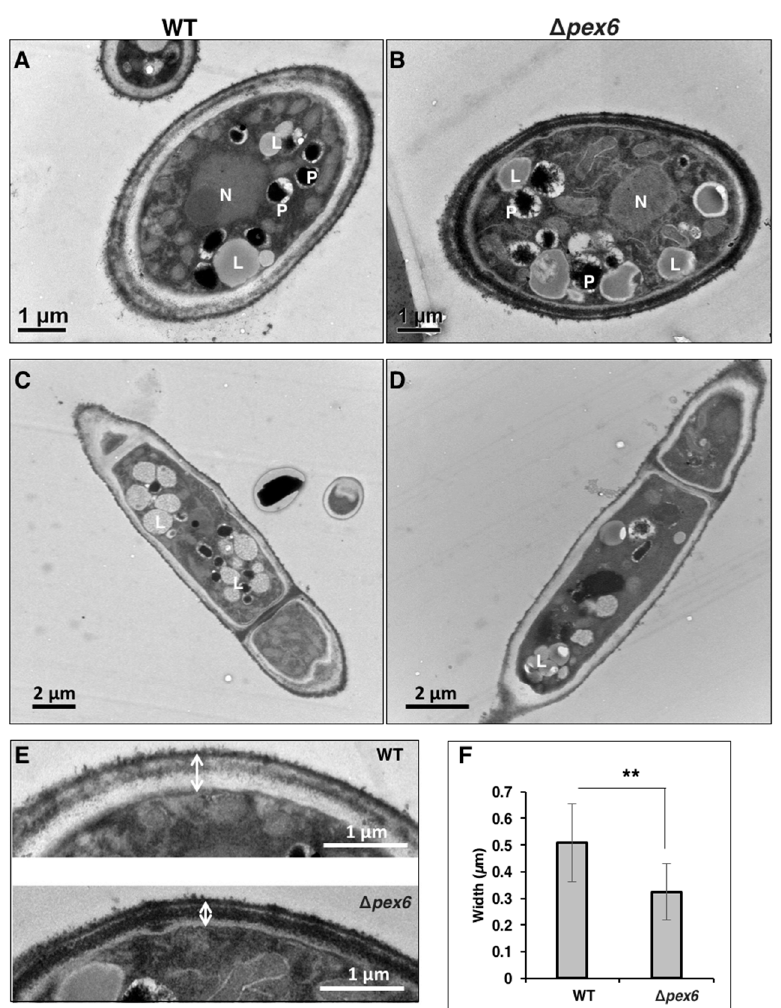
Figure 5. Transmission electron microscopy of A. alternata hyphae. ( A ) Cross section of a hypha of wild type (WT); ( B ) Cross section of a hypha of a pex6 mutant ( ∆ pex6 ); ( C ) Longitudinal section of a hypha of WT; ( D ) Longitudinal section of a hypha of ∆ pex6 . Abbreviations: N, nucleus; P, peroxisome; L, lipid body; ( E ) Images of fungal cell walls; ( F ) Measurement of cell-wall thickness. Means ( n = 30) indicated by asterisks are significantly different from one another, p < 0.01 (**).